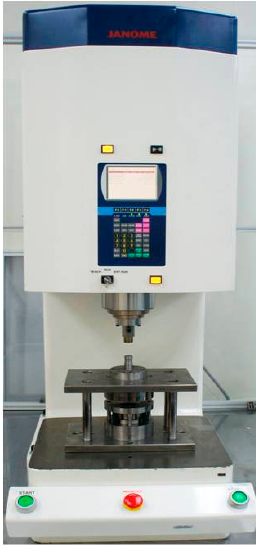
Figure 8. The electro press for the micro-channel array forming process (JANOME JP-5004).